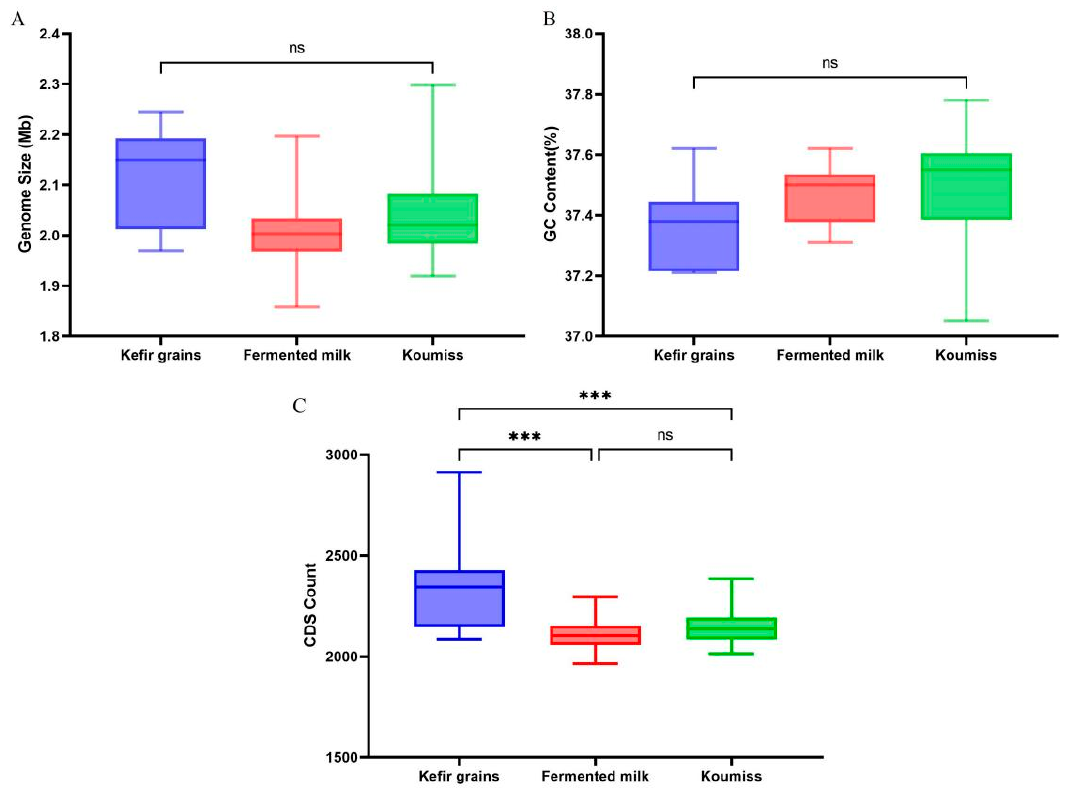
Figure 4. Genomic characteristics of L. kefiranofaciens strains isolated from different sources. ***: Sam- ples have a very large signi fi cant di ff erence. ns: Samples have no signi fi cant di ff erence. ( A ): Genome size of di ff erent isolates. ( B ): GC content of di ff erent isolates. ( C ): CDS count of di ff erent isolates.